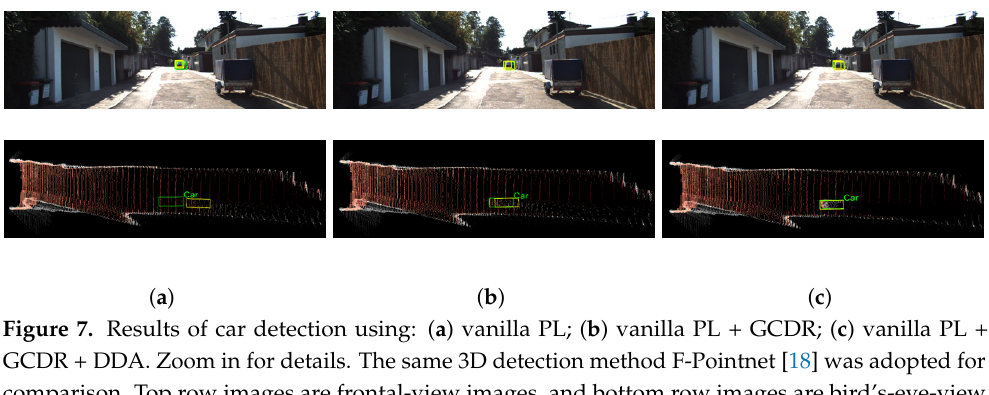
Figure 7. Results of car detection using: ( a ) vanilla PL; ( b ) vanilla PL + GCDR; ( c ) vanilla PL + GCDR + DDA. Zoom in for details. The same 3D detection method F-Pointnet [18] was adopted for comparison. Top row images are frontal-view images, and bottom row images are bird’s-eye-view point cloud maps. Ground truth boxes are in green, and prediction results are in